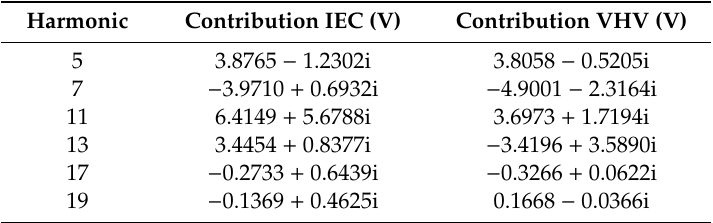
Table 4. Voltage distortion comparison (VDC) method: Calculated harmonic voltage distortion by the customer.